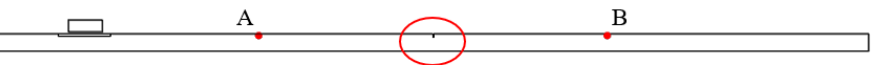
Figure 26. A defect with a width of 0.5 mm and a depth of 2 mm. Figure 27. The detection points of the reflected signal and the transmitted signal. (A: The detection point of the reflected signal. B: The detection point of the transmitted signal.)